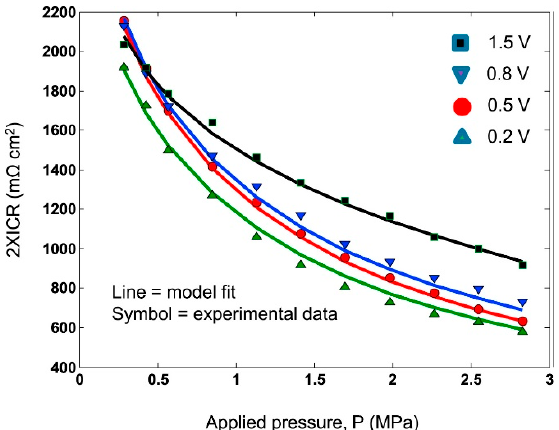
Figure 20. Potential impact on 316L steel contact resistance in sulfuric acid, pH = 3. Reprinted from [185] copyright (2014), with permission from Elsevier.